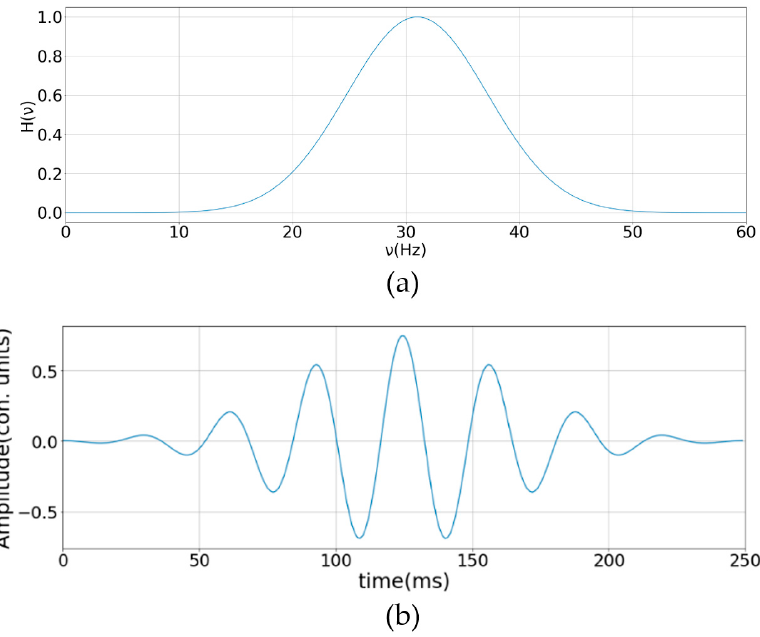
Figure 2. Frequency function of the designed filter (frequency axis is scaled) ( a ) and created kernel function ( b ) used in impulse response sense.